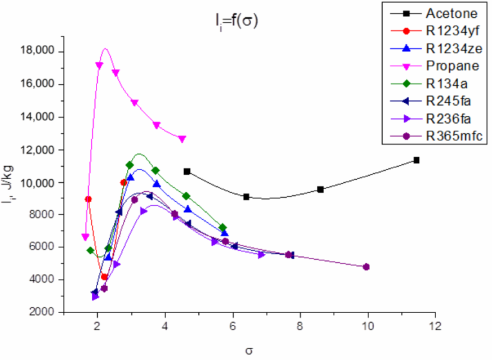
Figure 4. Internal work against pressure ratio for different working